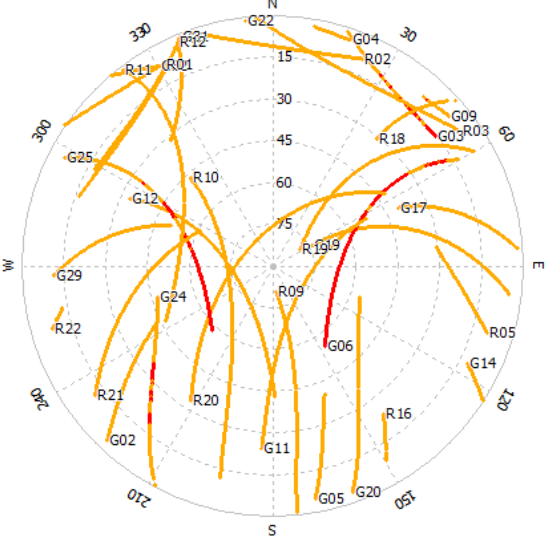
Figure 5. Sky plot for Samsung S20B (red: GPS satellites with L5 signals observed).